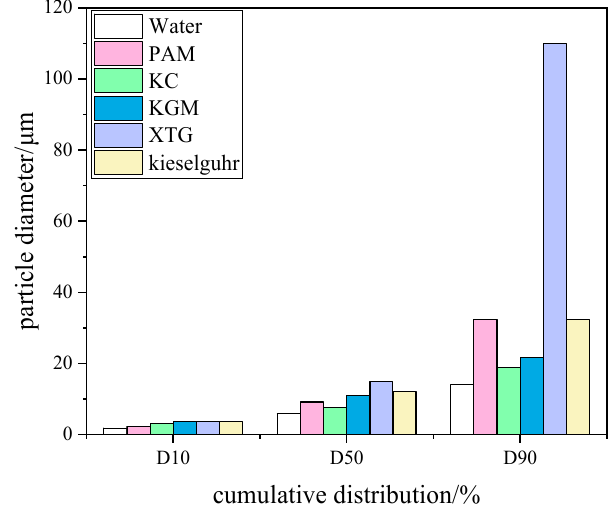
Figure 5. Histogram of particle size cumulative distribution of coagulant types.